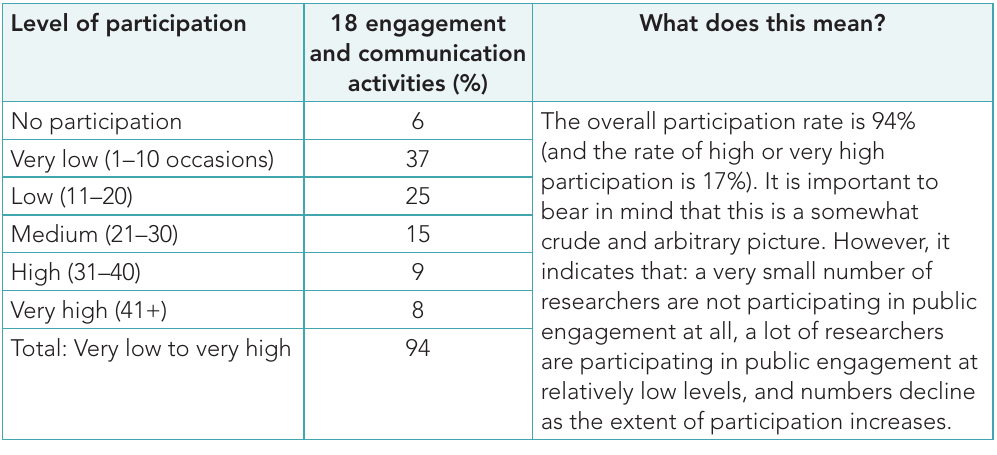
Table 2: Overall levels of participation Level of participation 18 engagement What does this mean? and communication activities (%) No participation 6 The overall participation rate is 94% (and the rate of high or very high participation is 17%). It is important to bear in mind that this is a somewhat crude and arbitrary picture. However, it indicates that: a very small number of researchers are not participating in public engagement at all, a lot of